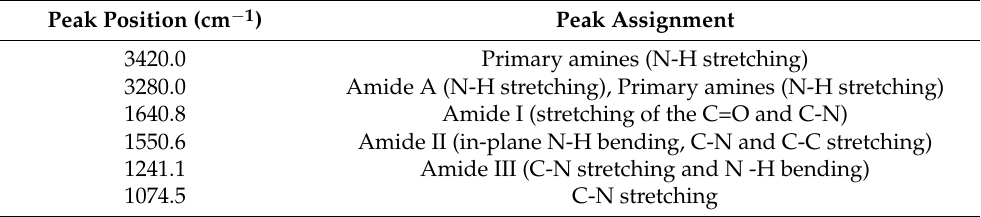
Table 1. Peak assignments associated with the formation of the amide bond in